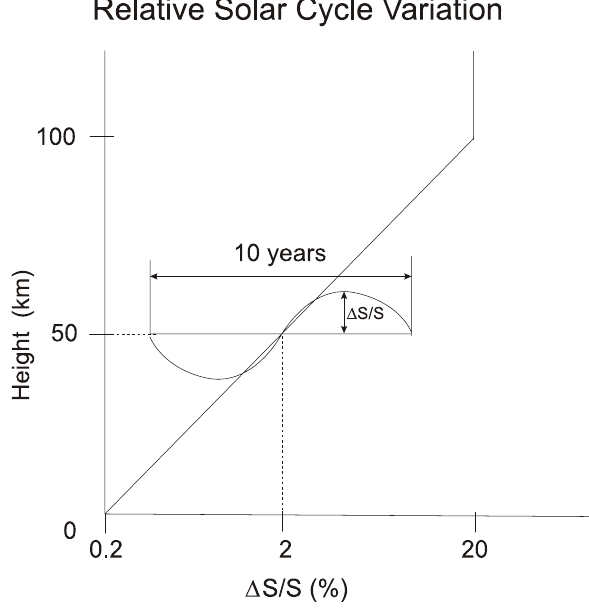
Fig. 2. Schematic, illustrating the adopted height profile for the relative amplitude of the SC variation on a logarithmic scale. The period of the SC variation is taken to be 10 years, and it is constant throughout the entire model